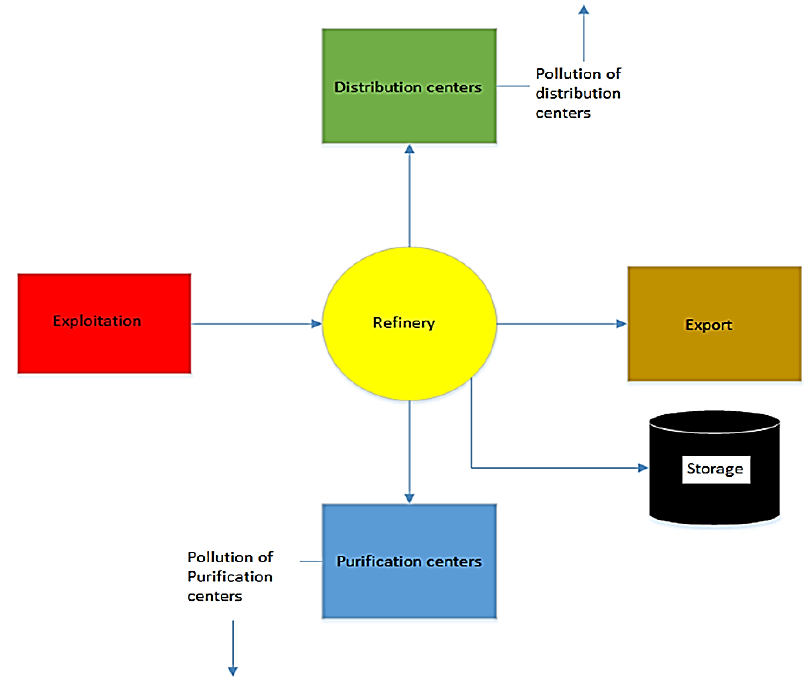
Fig. 1. The proposed supply chain